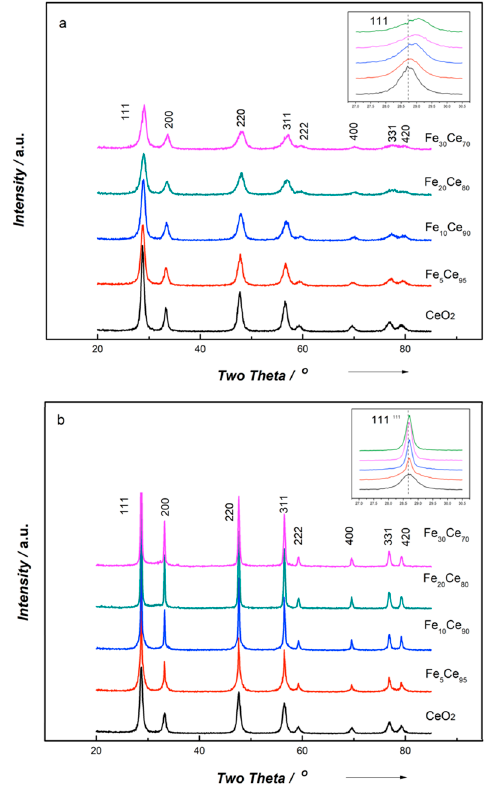
Figure 1. Powder X-ray diffraction patterns of ( a ) the co-precipitation method and ( b ) the solution combustion synthesis method.